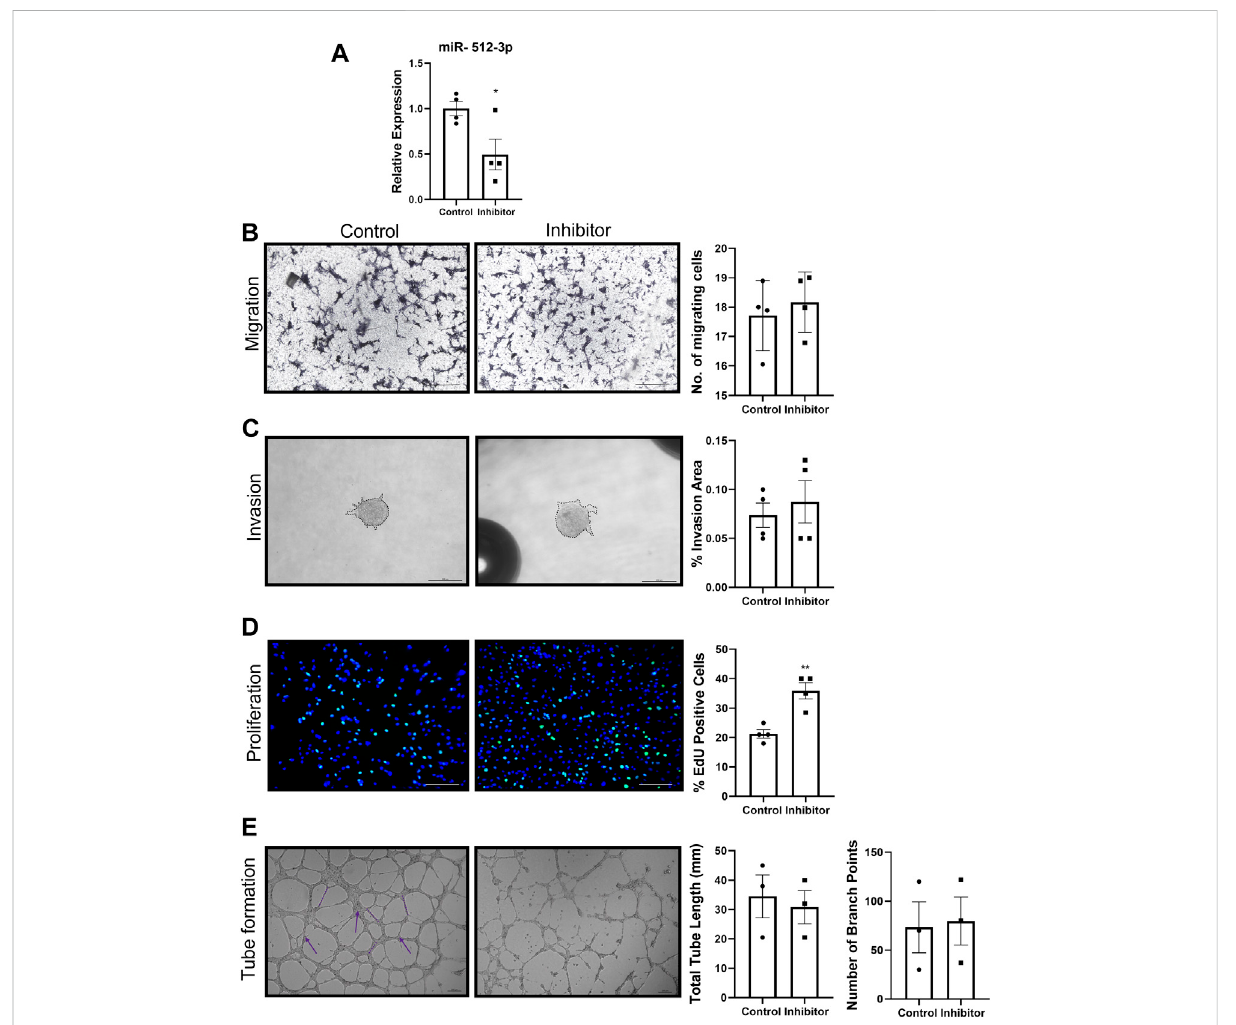
FIGURE 3 miR-512-3p knockdown promoted trophoblast proliferation. (A) Expression of miR-512-3p in mock-transfected HTR-8/SVneo cells (Control) or following transfection with miR-512-3p antisense oligonucleotide (Inhibitor). ( p < 0.05, n = 3 replicates). (B – E) All assays were conducted and quanti fi ed as indicated in fi gure legend 2. Migration (B) , invasion (C) and Tube formation (E) did not show any signi fi cant difference between control and miR-512-3p inhibitortreated cells. ( n = 3,4) (D) Proliferation quanti fi edby counting percent EdU-positive cells showed signi fi cant increase in inhibitor treated conditions vs. control. (** p ≤ 0.01, n = 4). All analysis were performed using Student ’ s t -test. Error bars extending to ±